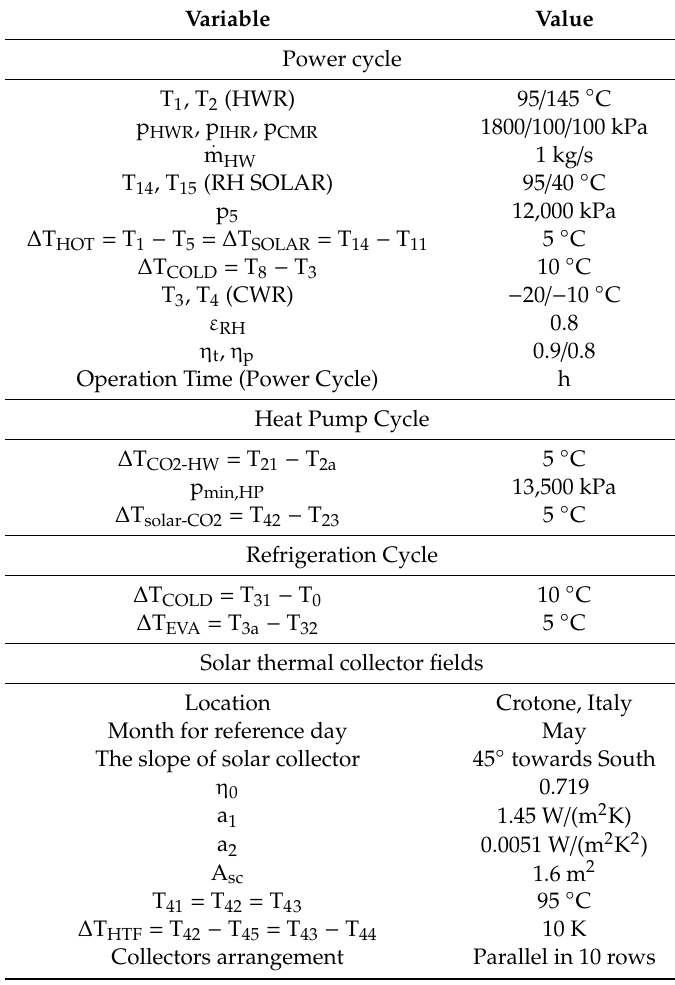
Table 2. TEES design operating